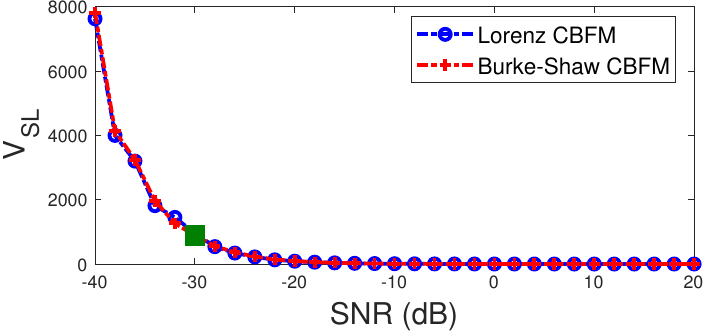
Figure 18. Sidelobe volume of the monostatic radar configuration for the Lorenz CBFM and Burke– Shaw CBFM waveforms plotted against the signal to noise ratio ( SNR ). The green square at SNR = − 30 dB indicate that for sidelobe levels are at the value of − 13.33